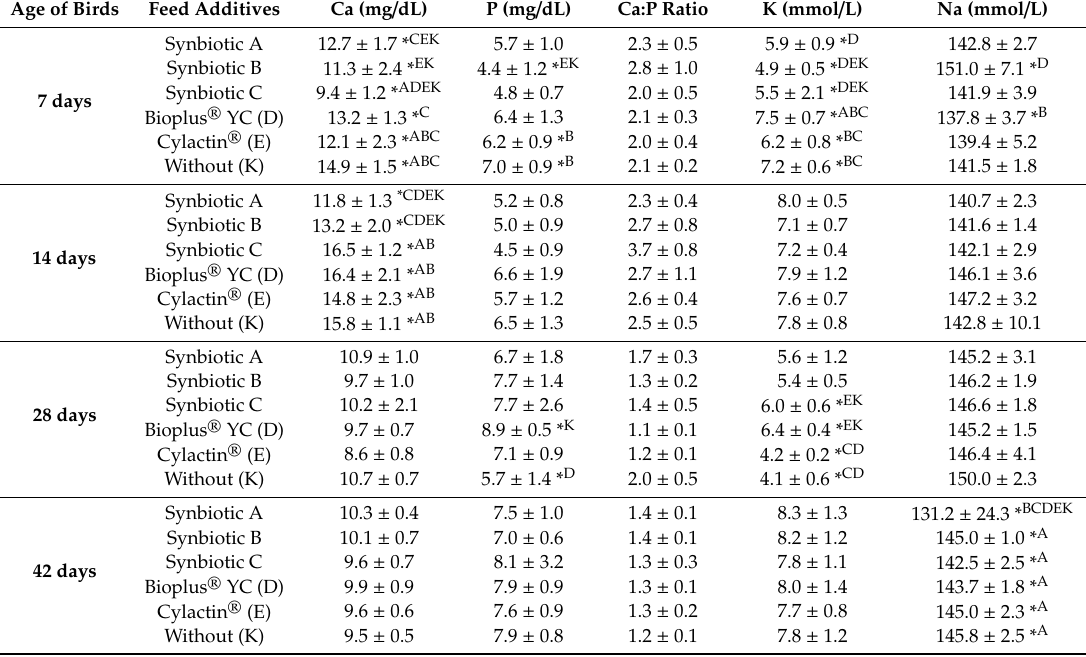
Table 7. Levels of the tested elements in the chicken blood serum. *—statistically significant di ff erences between groups, p ≤